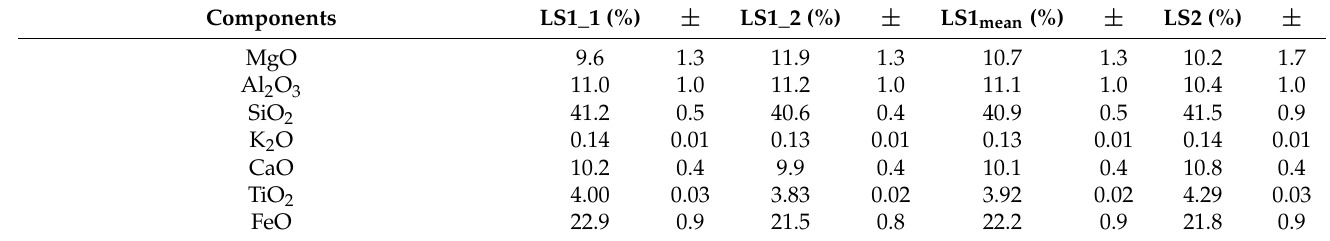
Table A1. Chemical compositions with their 1 σ statistical errors in wt.%, normalized to 99% on account of missing elements, such as Mn, Ni, Cr, P, and Na. The particle size is assumed to be 70 µ m. Components